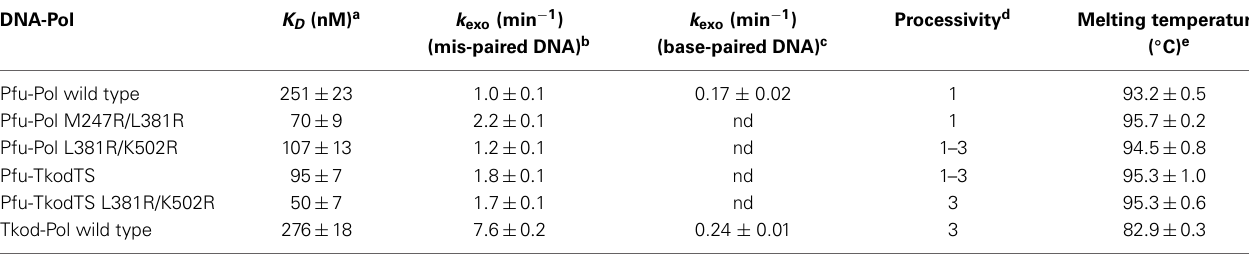
Table 2 | Summary of the properties of the polymerases investigated.